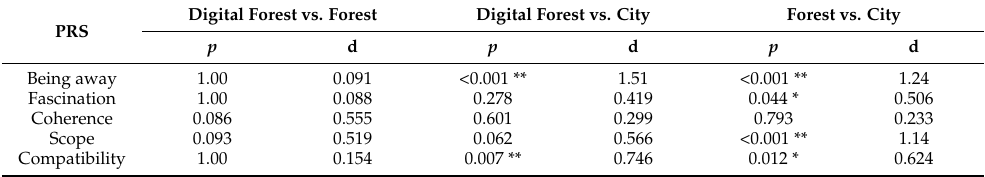
Table 14. Comparison results by PRS in three settings (multiple comparisons). Digital Forest vs. Forest Digital Forest vs. City Forest vs. PRS